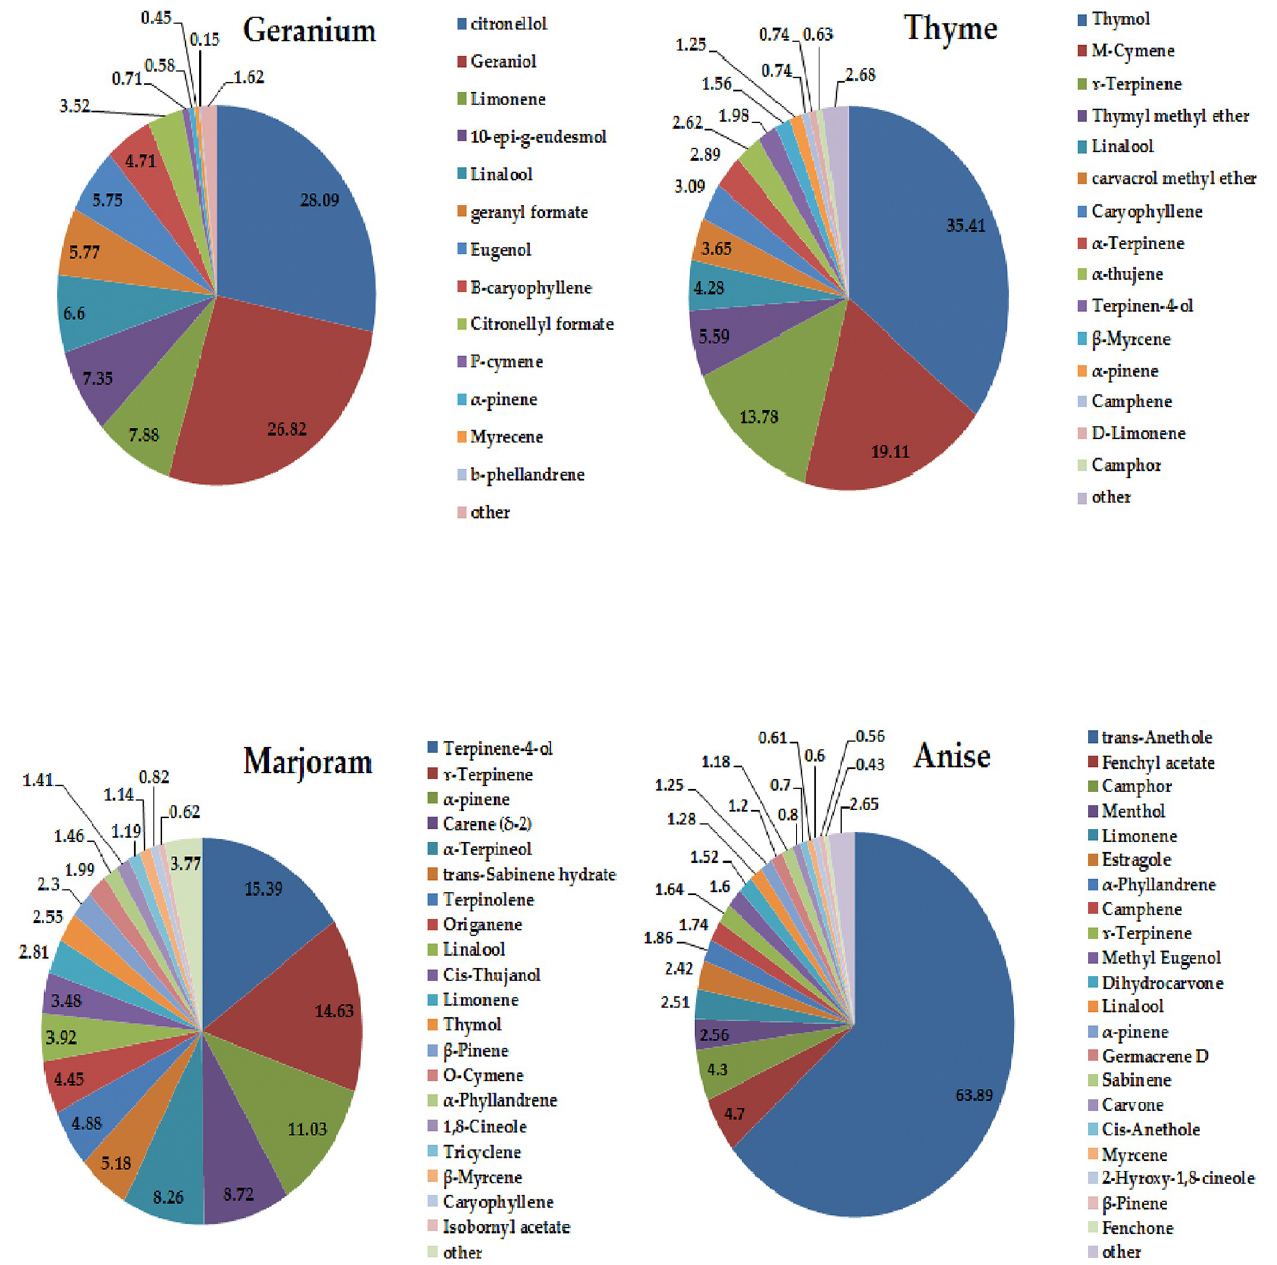
Fig 1. GC-mass analysis of geranium, thyme, marjoram, and anise essential oils.